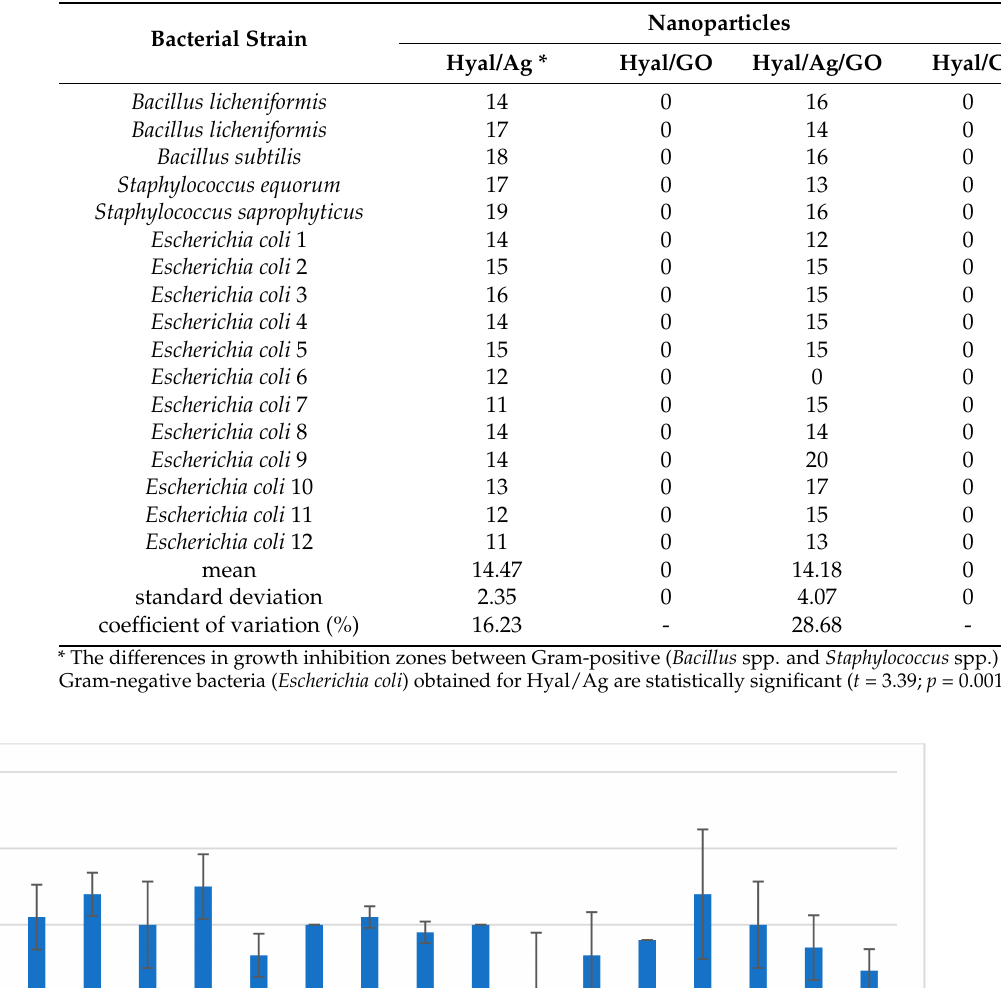
Table 4. Growth inhibition of bacterial strains tests caused by the silver nanoparticle composites (mm). The results are means of three replicates.